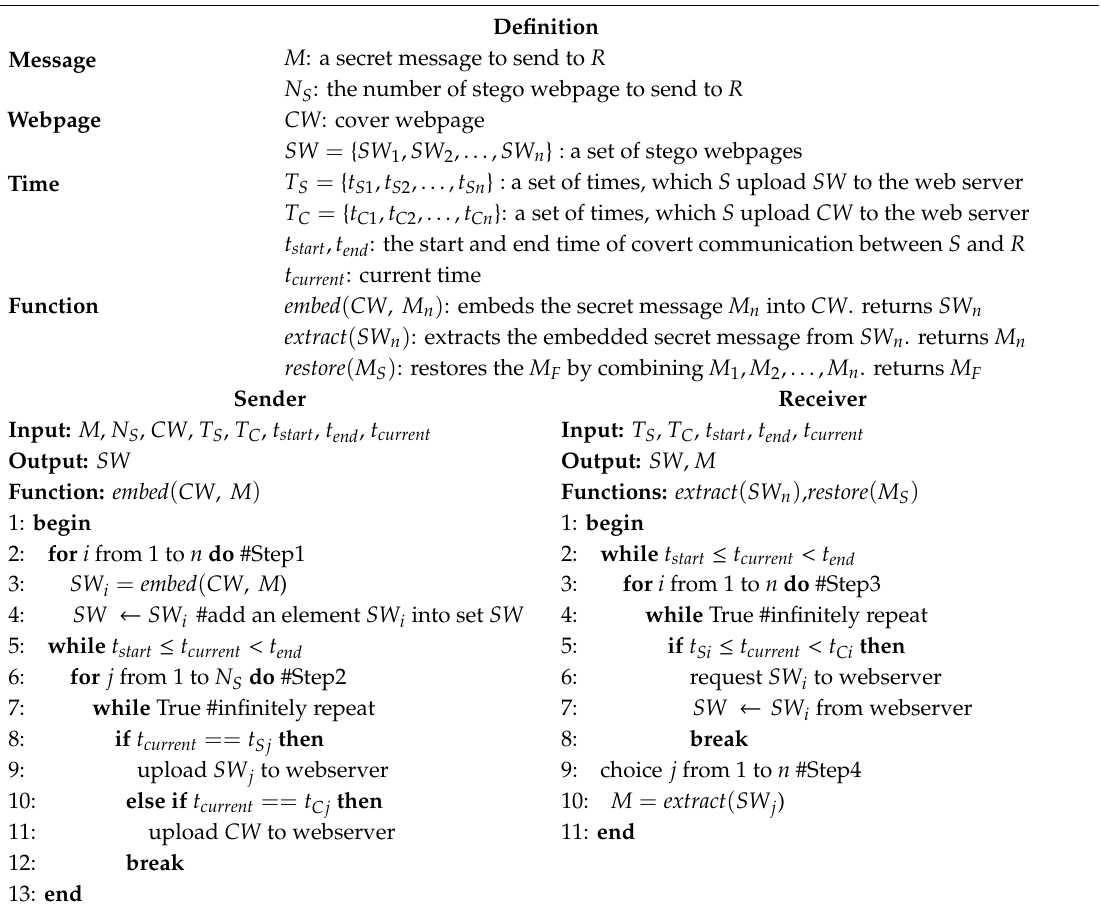
Algorithm 2 TDOA-U (Time-based Dynamic Operation Algorithm for